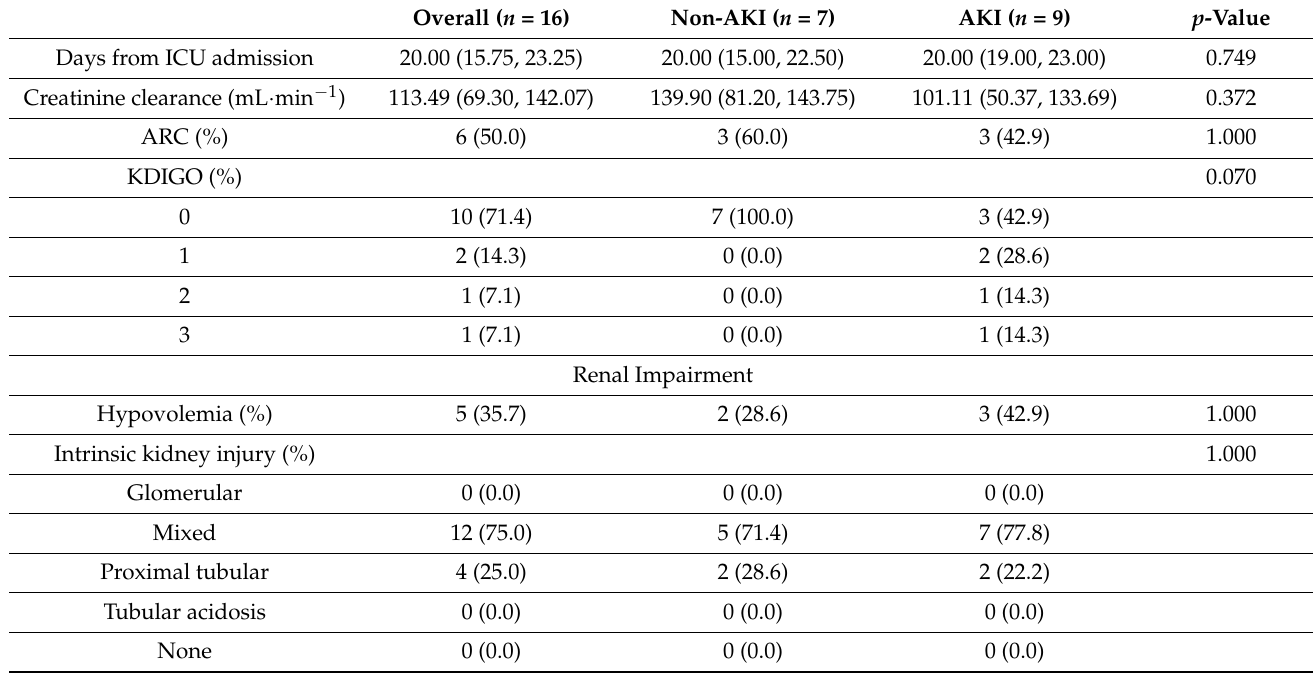
Table 3. Kidney abnormalities on ICU